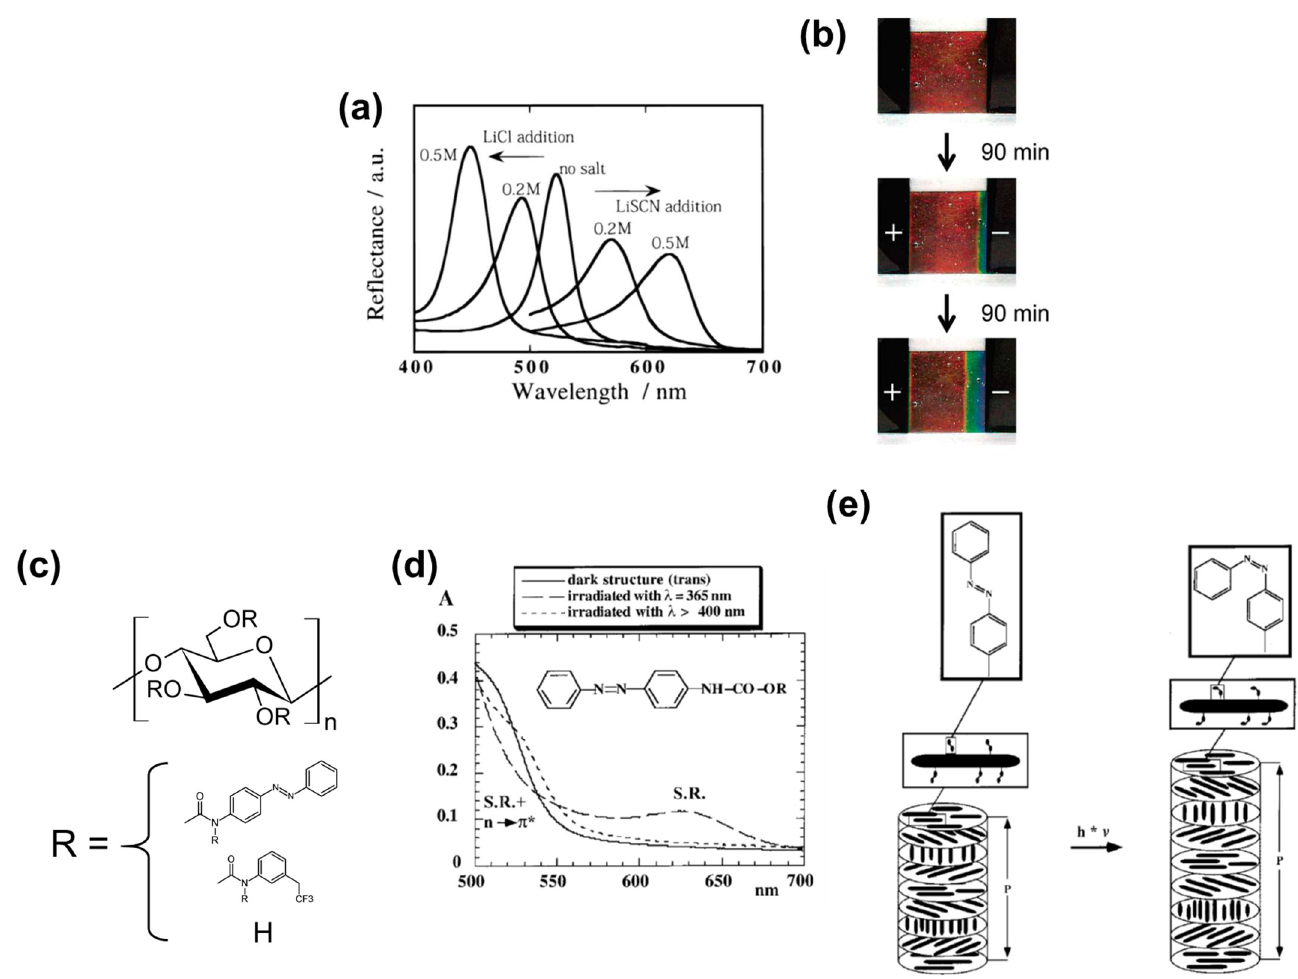
Figure 11. (a) Ultraviolet–visible (UV-Vis) spectra of hydroxypropyl cellulose (HPC) cholesteric liquid crystal (ChLC) aqueous solutions with various concentrations of LiCl and LiSCN. ( b ) Visual appearance of HPC ChLC aqueous solutions with LiSCN under application of an electric field ( a , b ) were reprinted with permission from [91,92]. Copyright (2021) American Chemical Society). ( c ) Chemical structure of azo-cellulose. ( d ) UV–Vis spectra of an azo-cellulose ChLC solution prior to irradiation, after irradiation at 356 nm, and after irradiation at >400 nm. ( e ) Schematic of the change in the cholesteric helical pitch of azo-cellulose ChLC solutions by irradiation ( d , e ) were reproduced from [51] by permission of Wiley).